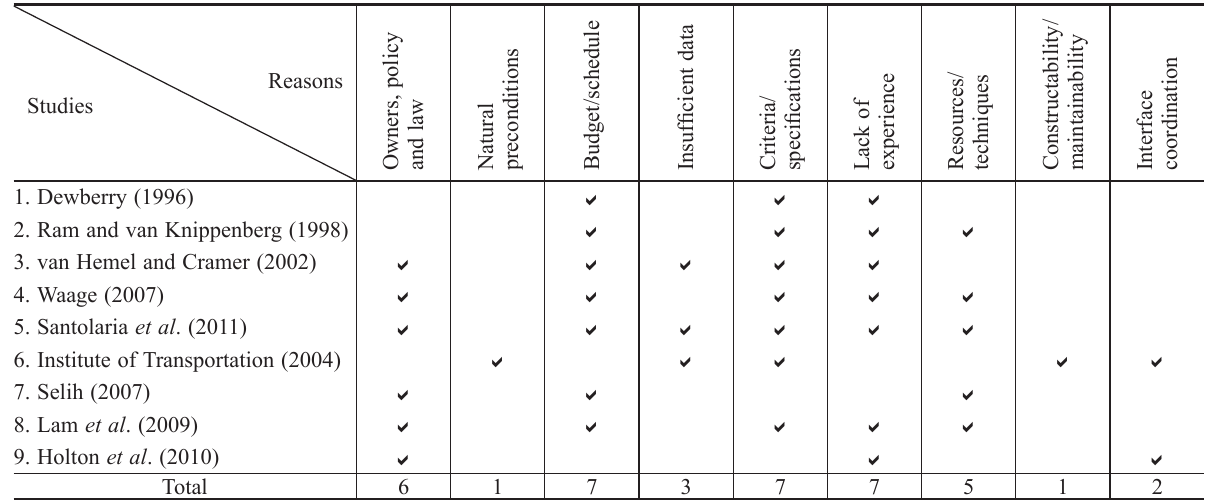
Table 1. Difficulty reasons for implementing sustainable